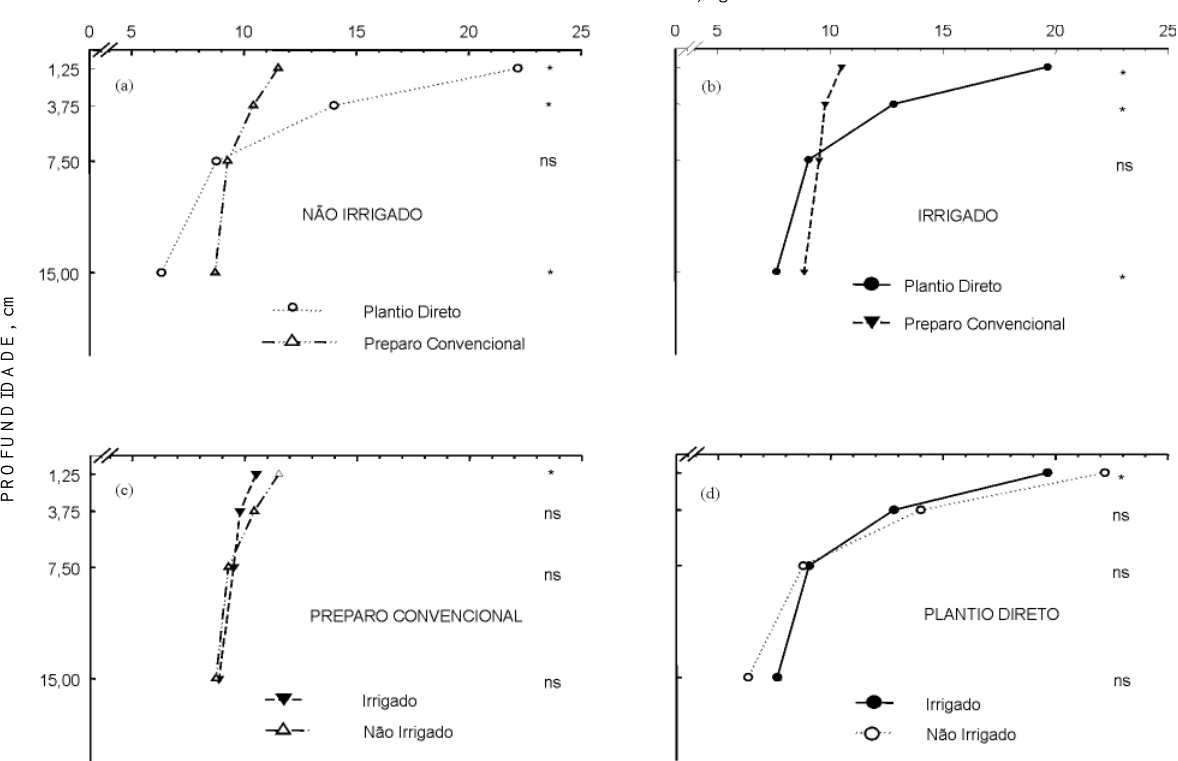
Figura 1. Concentração de C orgânico em Argissolo Vermelho, considerando o sistema de preparo de solo nas áreas (a) não irrigada e (b) irrigada e a irrigação no solo em (c) preparo convencional e (d) plantio